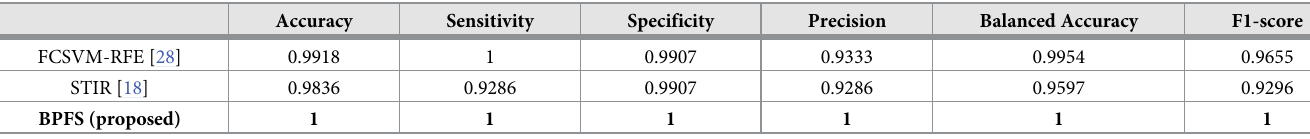
Table 3. Classification effectiveness analysis on the KIRC cancer dataset.